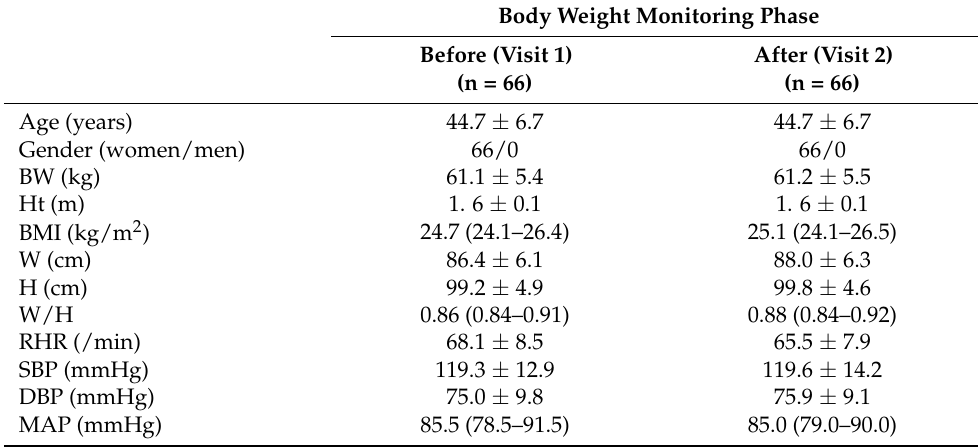
Figure 2. CONSORT flow diagram. Table 1. Characteristics of participants (who completed supplementation phase; n = 66) before and after BW monitoring